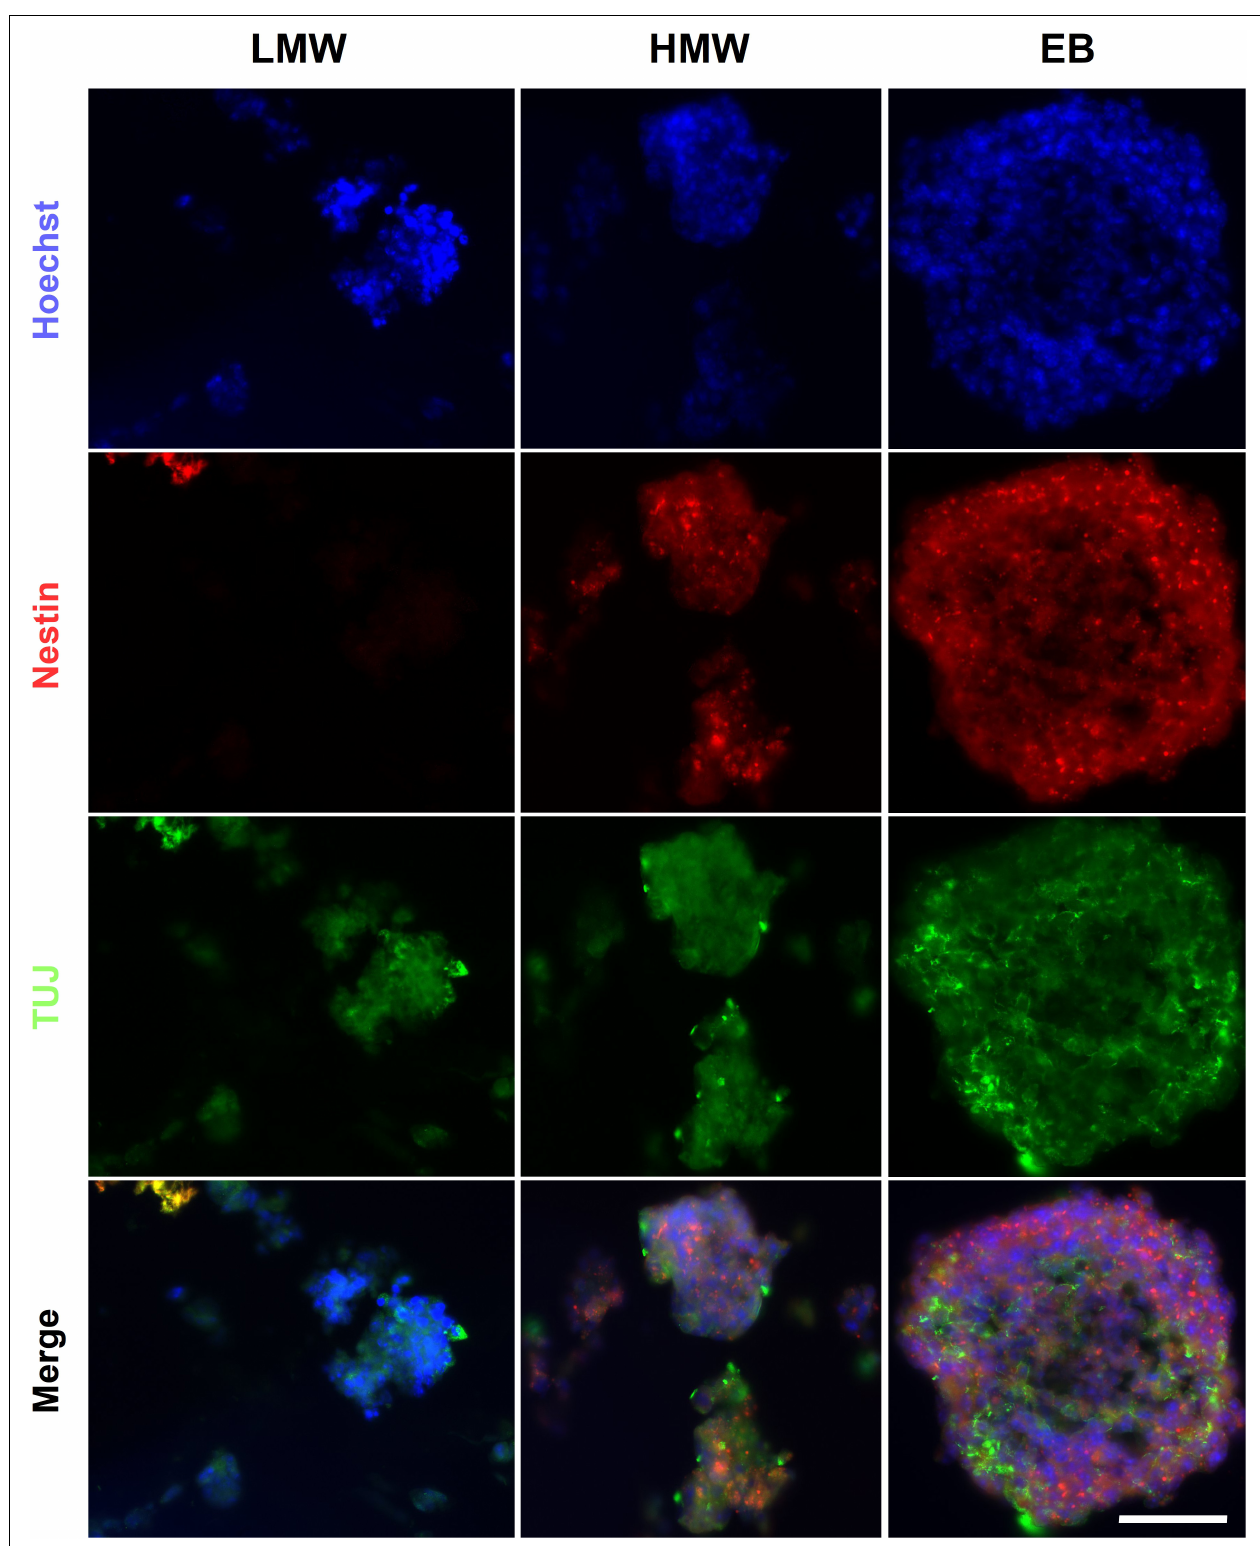
FIGURE 9 | CGR8 differentiation in Boyden chamber co-cultures with RA producing HGF11 MN. Representative ICC images of markers of the 3 germ layers in EBs and aggregates of CGR8 cells encapsulated in LMW and HMW alginate beads. Images collected from n = 4 independent experiments. Scale Bar: 50 µ m.